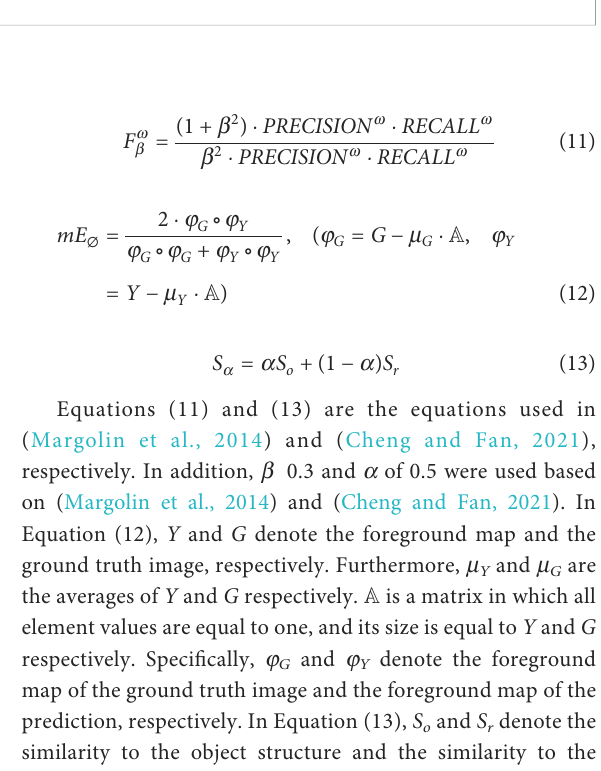
FIGURE 3 Graphs of losses and accuracies with (A) training and (B) validation data. (Orange and blue lines represent loss and accuracy,